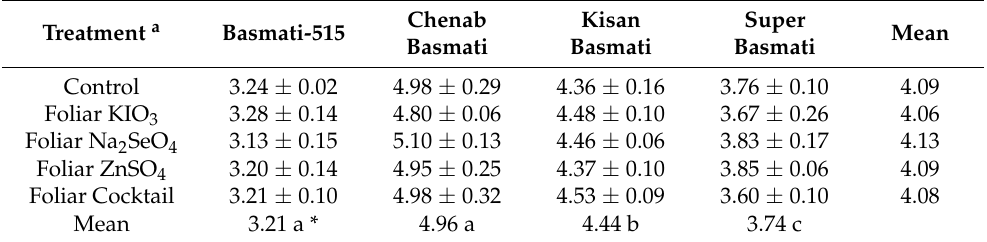
Table 2. Effect of foliar treatments on paddy yield (Mg ha − 1 ) of different cultivars of Basmati rice. Treatment a